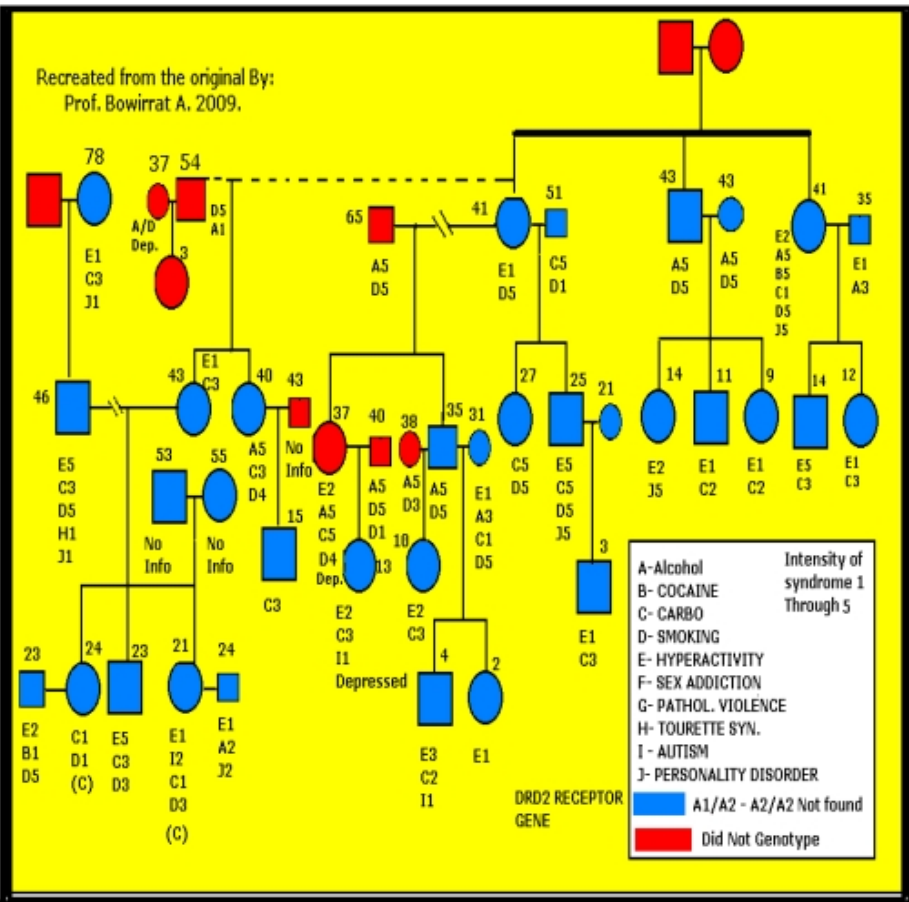
Figure 3. Genotypic results of the Dopamine D2 receptor gene (DRD2) polymorphism of family A (N = 32) corresponded with multiple Reward Deficiency Syndrome (RDS) behaviors [96].